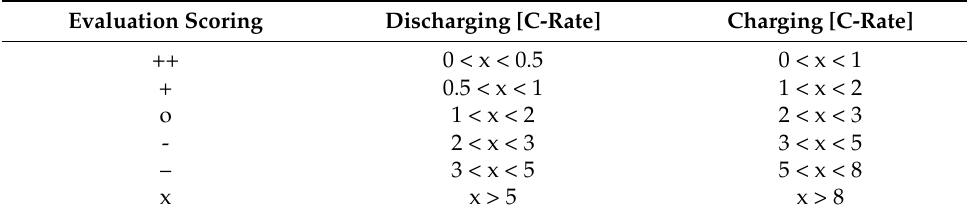
Table A2. Conversion table used for discharging and charging